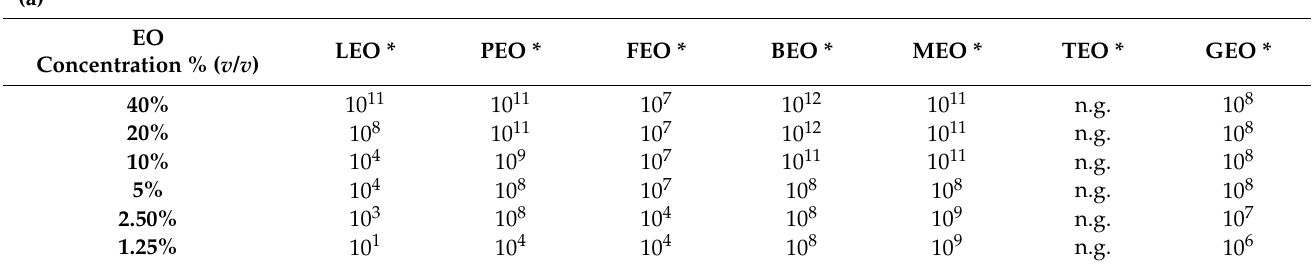
Table 2. Bacterial growth reduction rate, expressed as log 10 CFU/mL compared to positive control, based on different EO concentrations. ( a ) E. coli ATCC growth reduction rate; ( b ) E. coli clinical isolate 462/20 reduction rate; ( c ) S. aureus ATCC reduction rate; ( d ) S. aureus clinical isolate 463/20 reduction rate. Acronyms: EO: Essential Oil; LEO: Citrus Lemon ; PEO: Pinus Sylvestris ; FEO: Feoniculum Vulgare